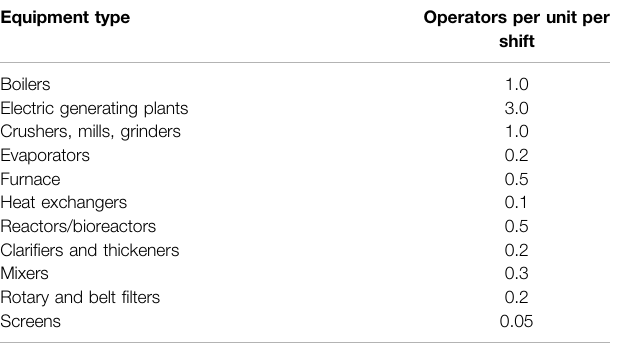
TABLE 3 | Assumptions for operator requirements for various types of process equipment (Brown and Brown 2014). Equipment type